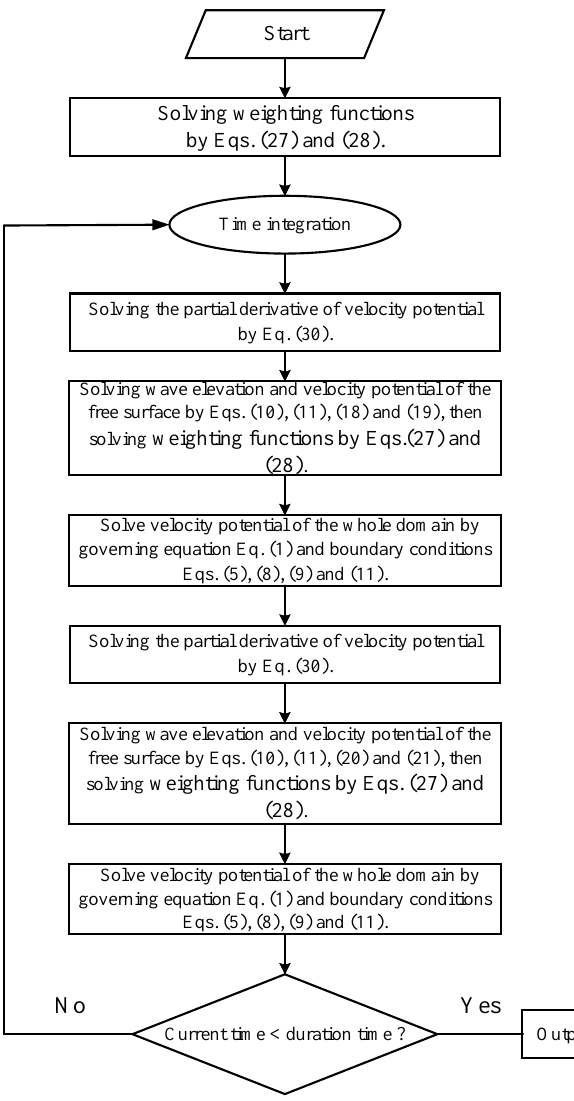
Figure 2. The flowchart of the present GFDM